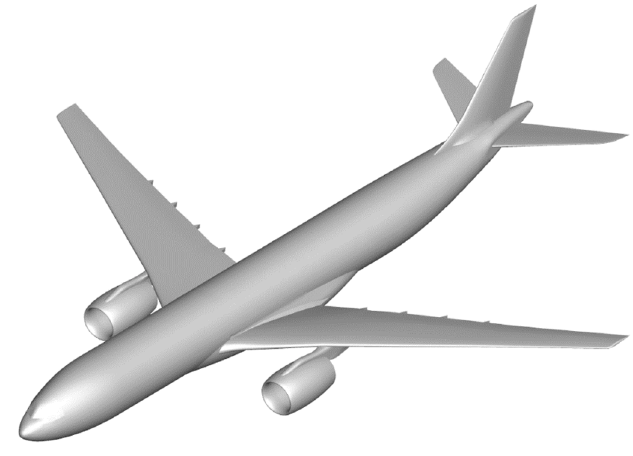
Figure 1. Geometry of the XRF1 configuration. Table 1. Global parameters of the XRF1-DLR-C.